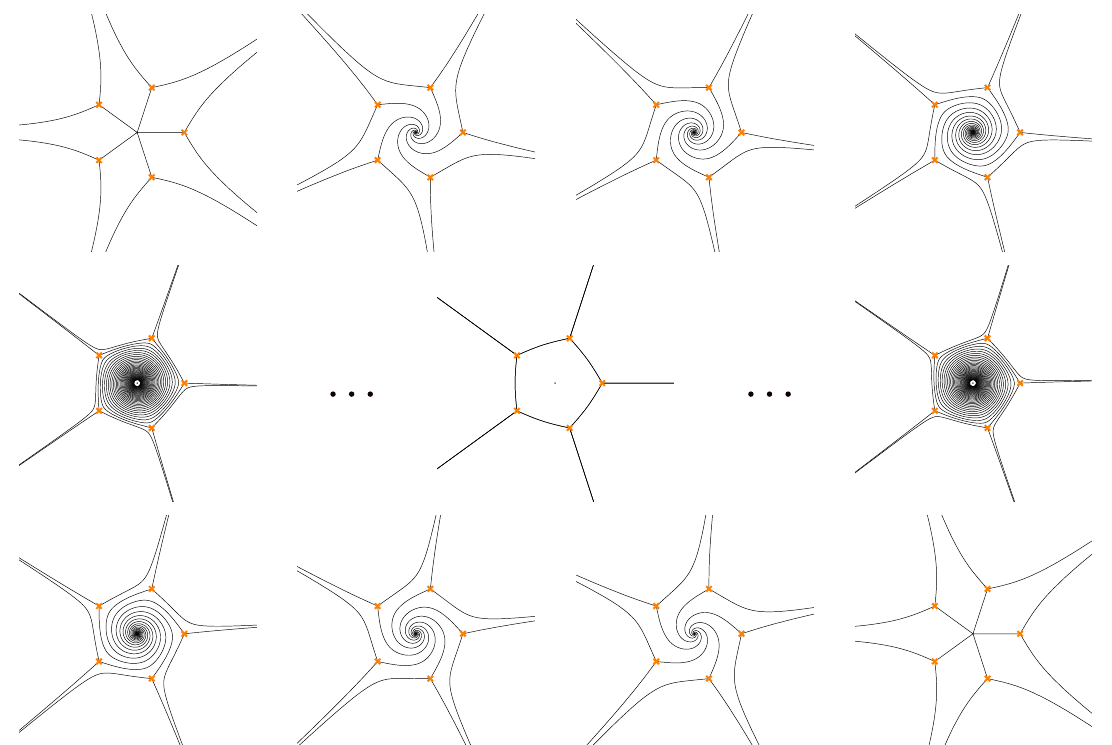
Figure 18. Sequence of spectral networks of the ( A 1 ; D 5 ) Argyres-Douglas theory.